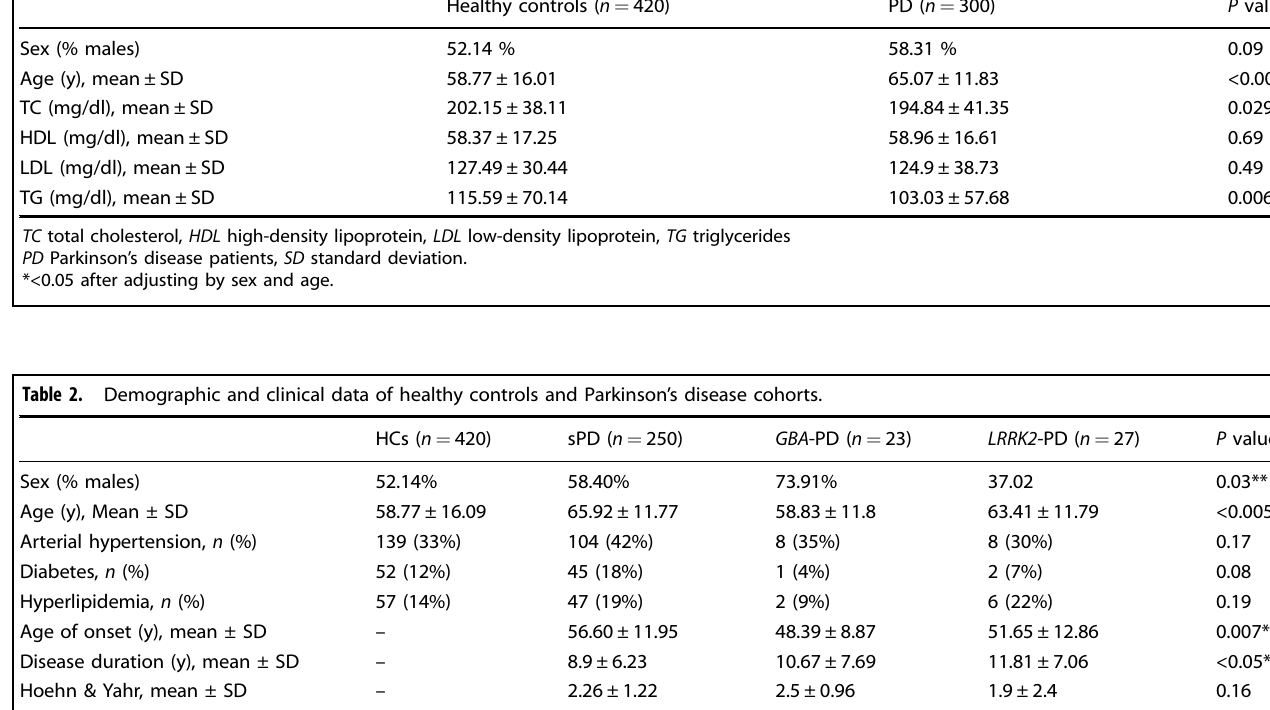
Table 1. Demographic characteristic and lipid pro fi le of healthy controls and Parkinson ’ s disease patients. Healthy controls ( n = 420)